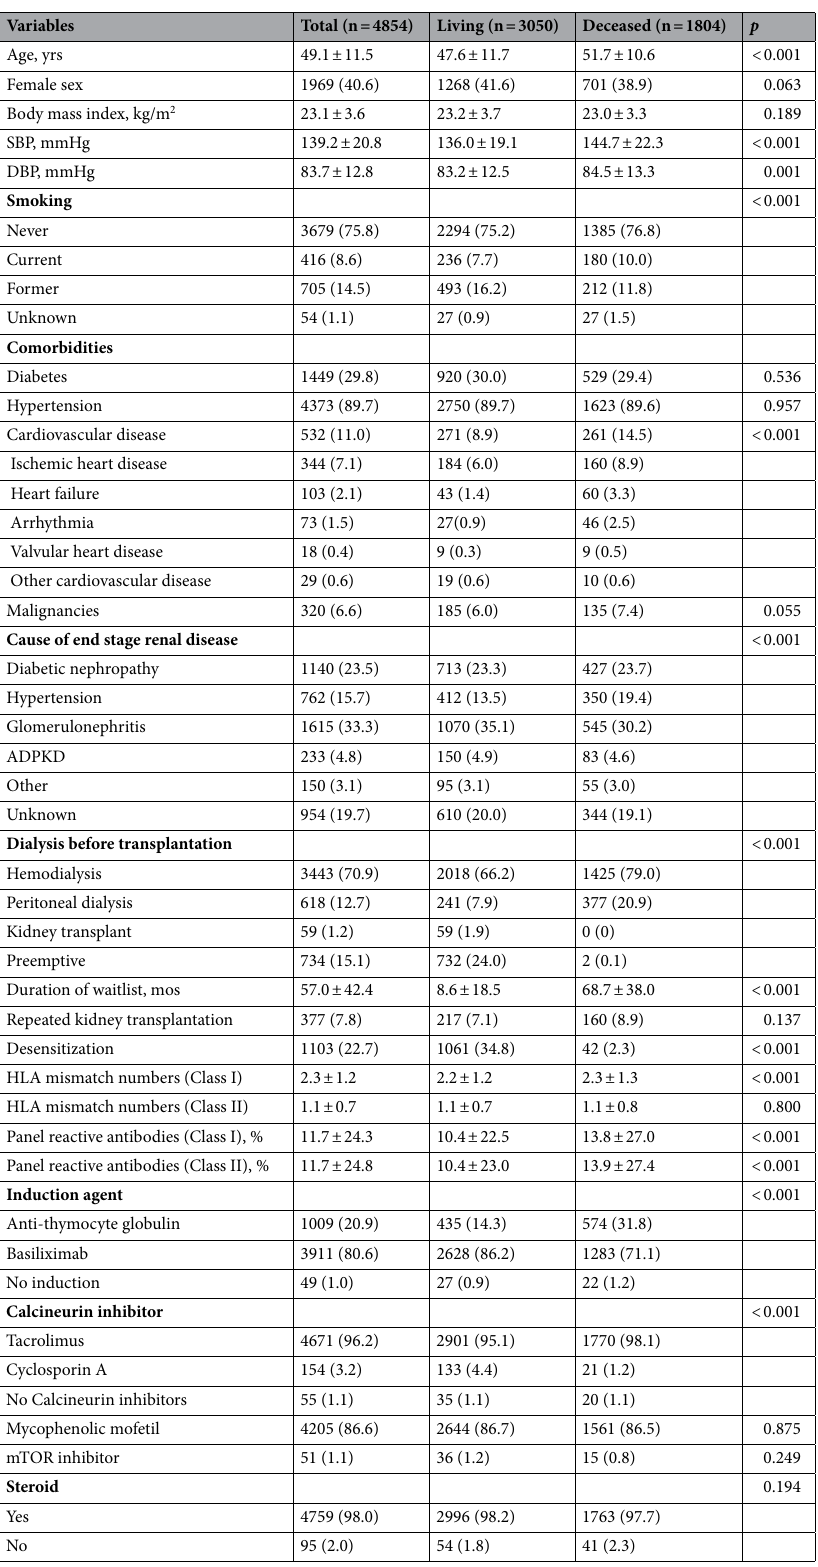
Table 1. Baseline clinical characteristics of the kidney transplant recipients of Korean Organ Transplantation Registry (2014–2018). ADPKD, autosomal dominant polycystic kidney disease; DBP, diastolic blood pressure; HLA, human leukocyte antigen; SBP, systolic blood pressure. Data are presented as number (%) or mean ± standard